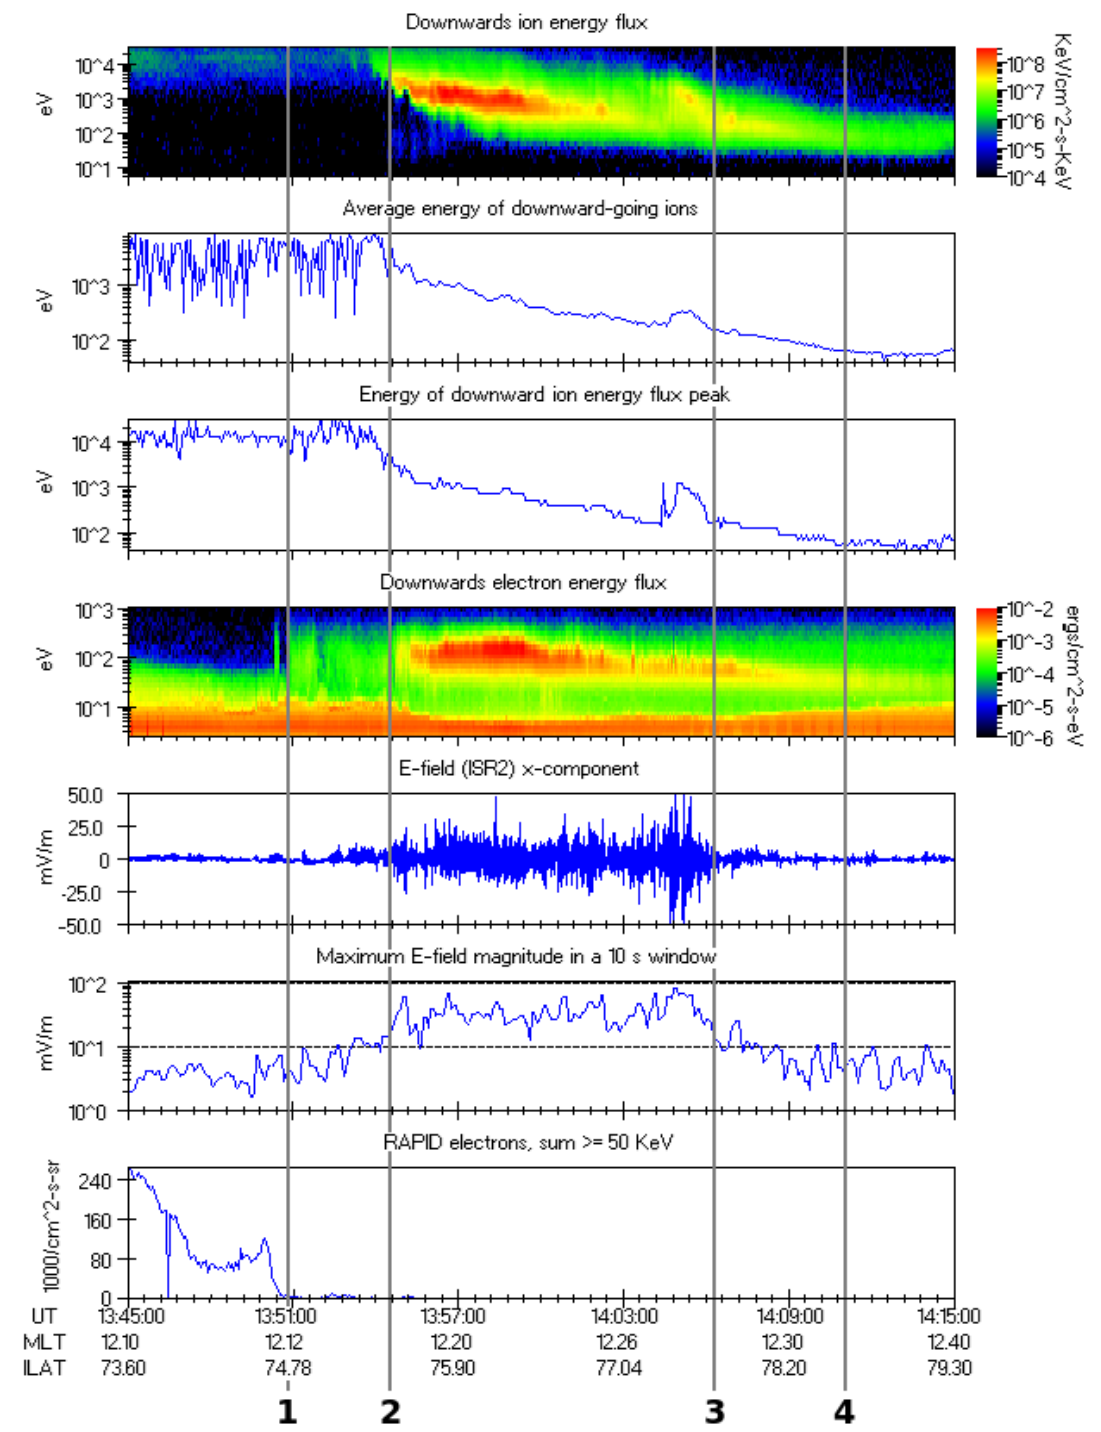
Fig. 1. An example of a cusp pass, with vertical lines marking the boundaries of interest. 1: The open/closed boundary. Identified by the magnetosheath electron edge and by the drop in energetic electron flux. 2: The start of the cusp ion dispersion, in this case coinciding with the onset of BB-ELF. 3: The end of the BB-ELF region. 4: The end of the cusp ion